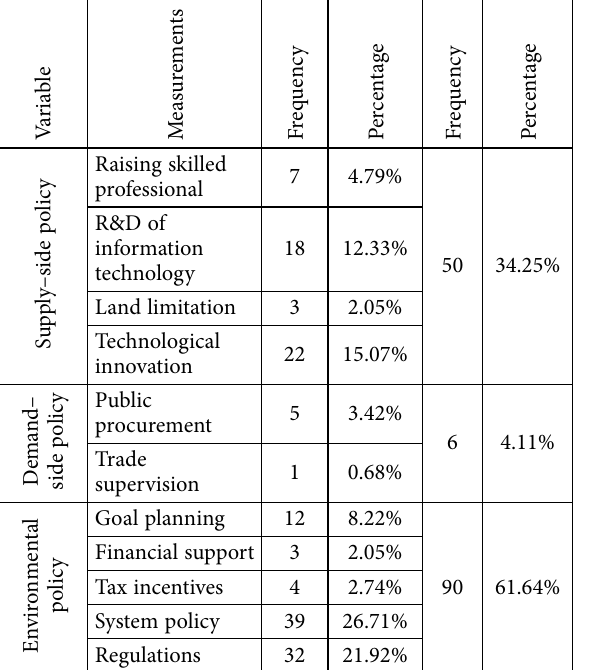
Table 5. Details of PB policies